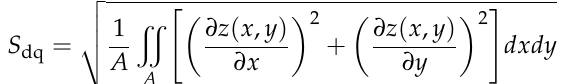
Figure 2. Three-dimensional topographic maps measured with an optical profilometer for two representative AISI 430 ferritic stainless steel samples with different visual appearances: with a mirror-like finish ( a ) and with a presence of haze ( b ).